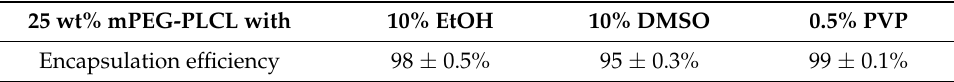
Table 2. Encapsulation Efficiency (EE%) of Tacrolimus with different cosolvent in 25 wt% of mPEG- PLCL where 10 wt% of FK506 was loaded.